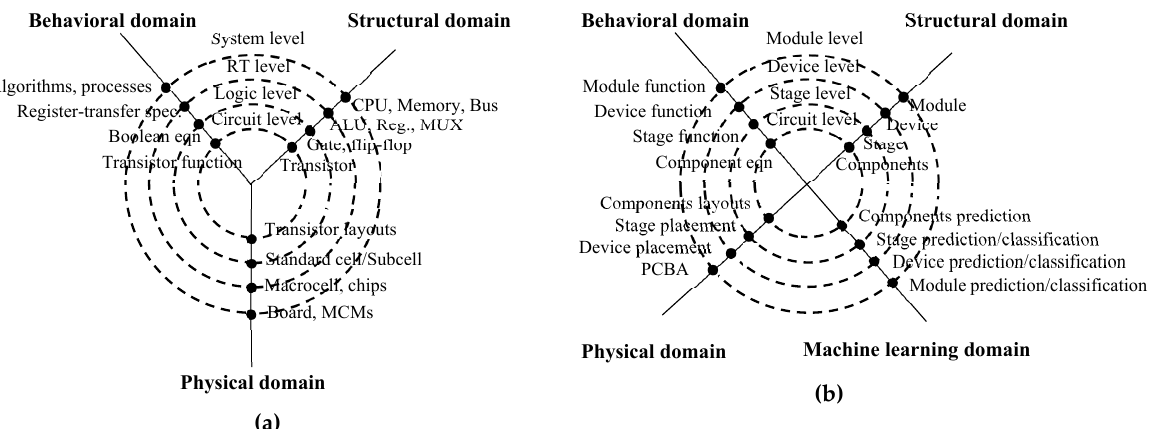
Figure 1. Design process depicted by: ( a ) Gajski-Kuhn Y-chart [22]; ( b ) proposed X-chart for analog design through machine learning.